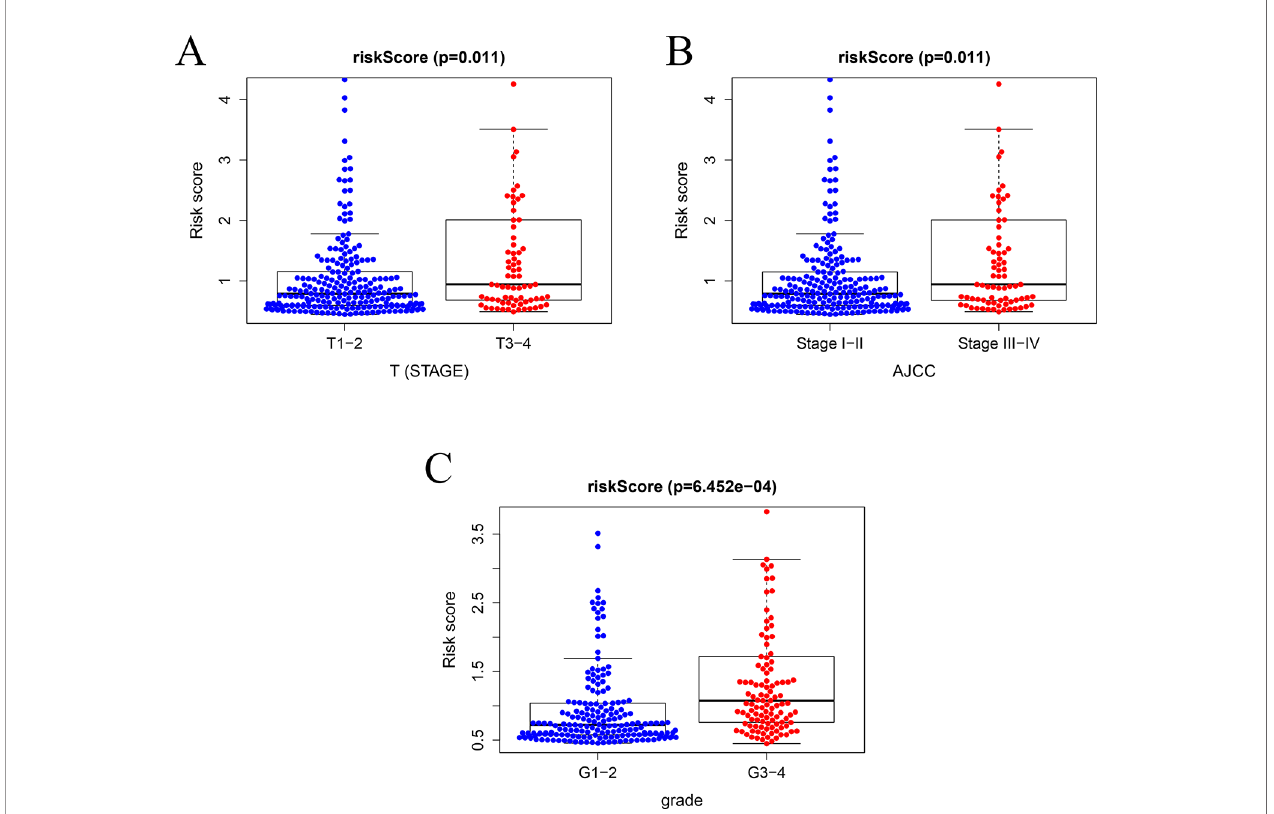
FIGURE 10 | Relationships between risk score and clinical features. (A) Relationships between risk score and T stage, (B) between risk score and AJCC stage, and (C) between risk score and